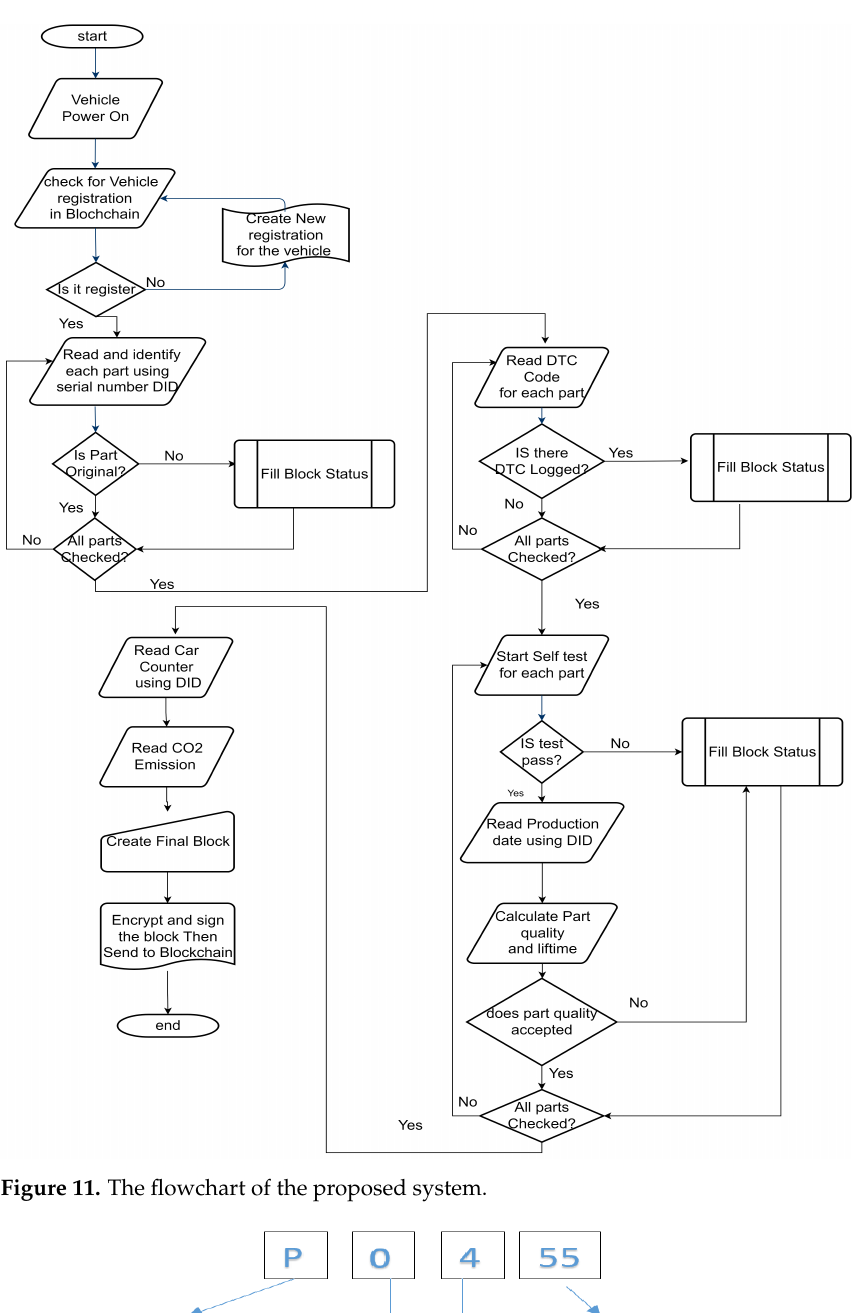
Figure 11. The flowchart of the proposed system.